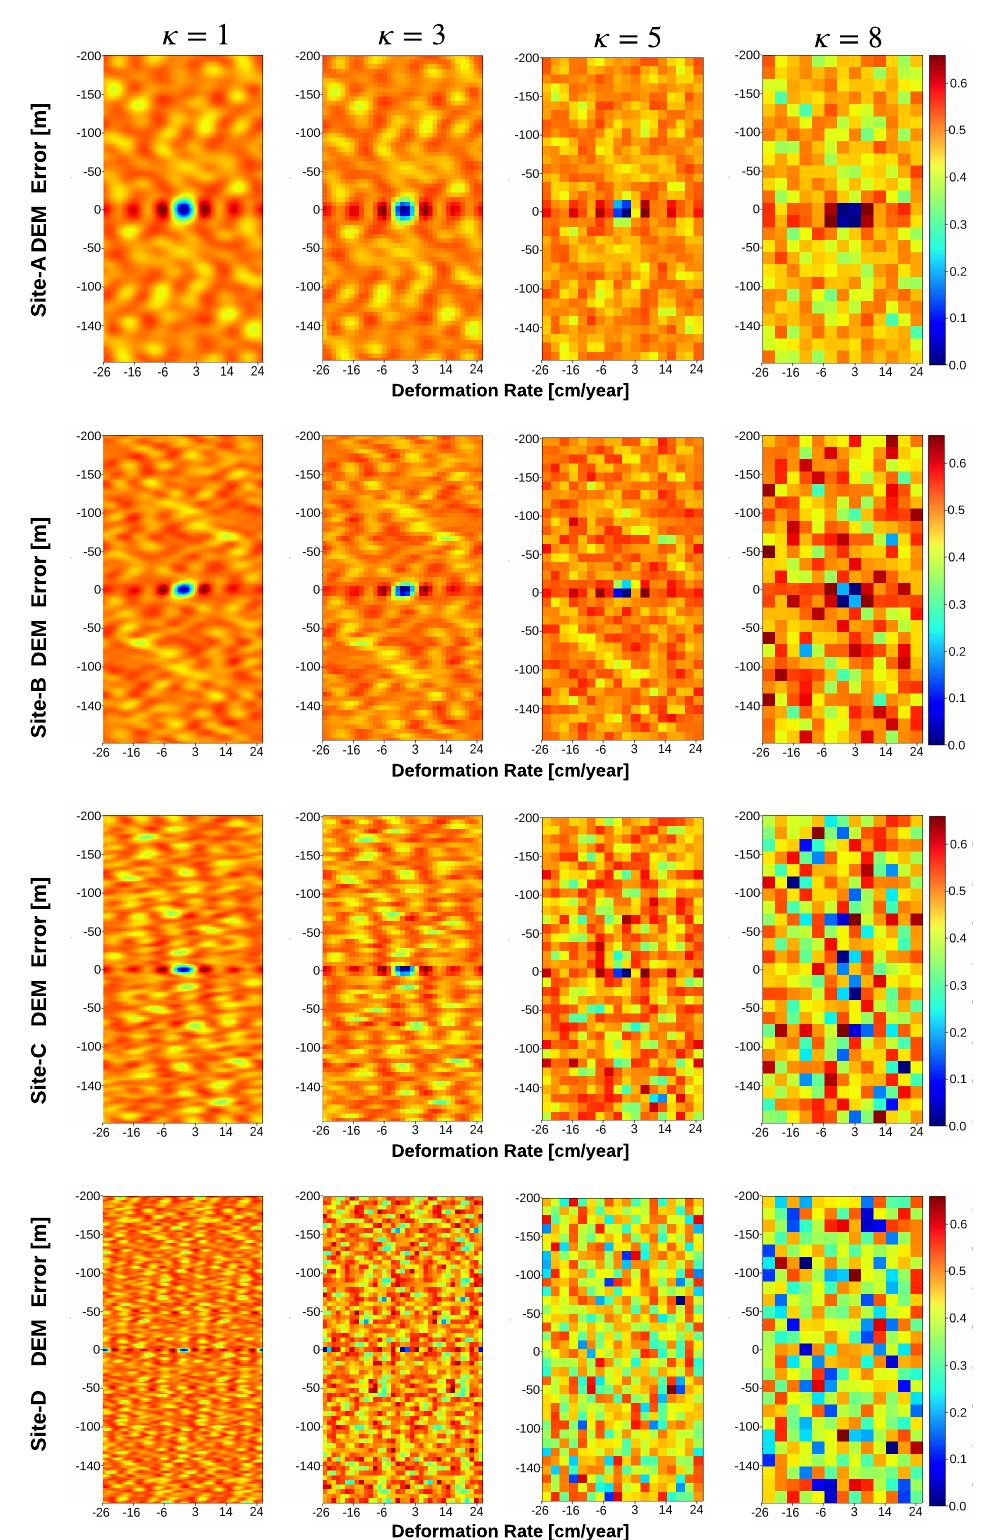
Figure 4. The landscape of loss function. Each row represents the loss landscapes that corresponds to real–world baselines with synthetic 0 deformation and 0 DEM error, and each column shows the results under different step sizes of grid sampling. The linear deformation rate x –axis and DEM error y –axis form a 2D solution space for an InSAR pixel location. The value is calculated by Equation (7) with selected real-world